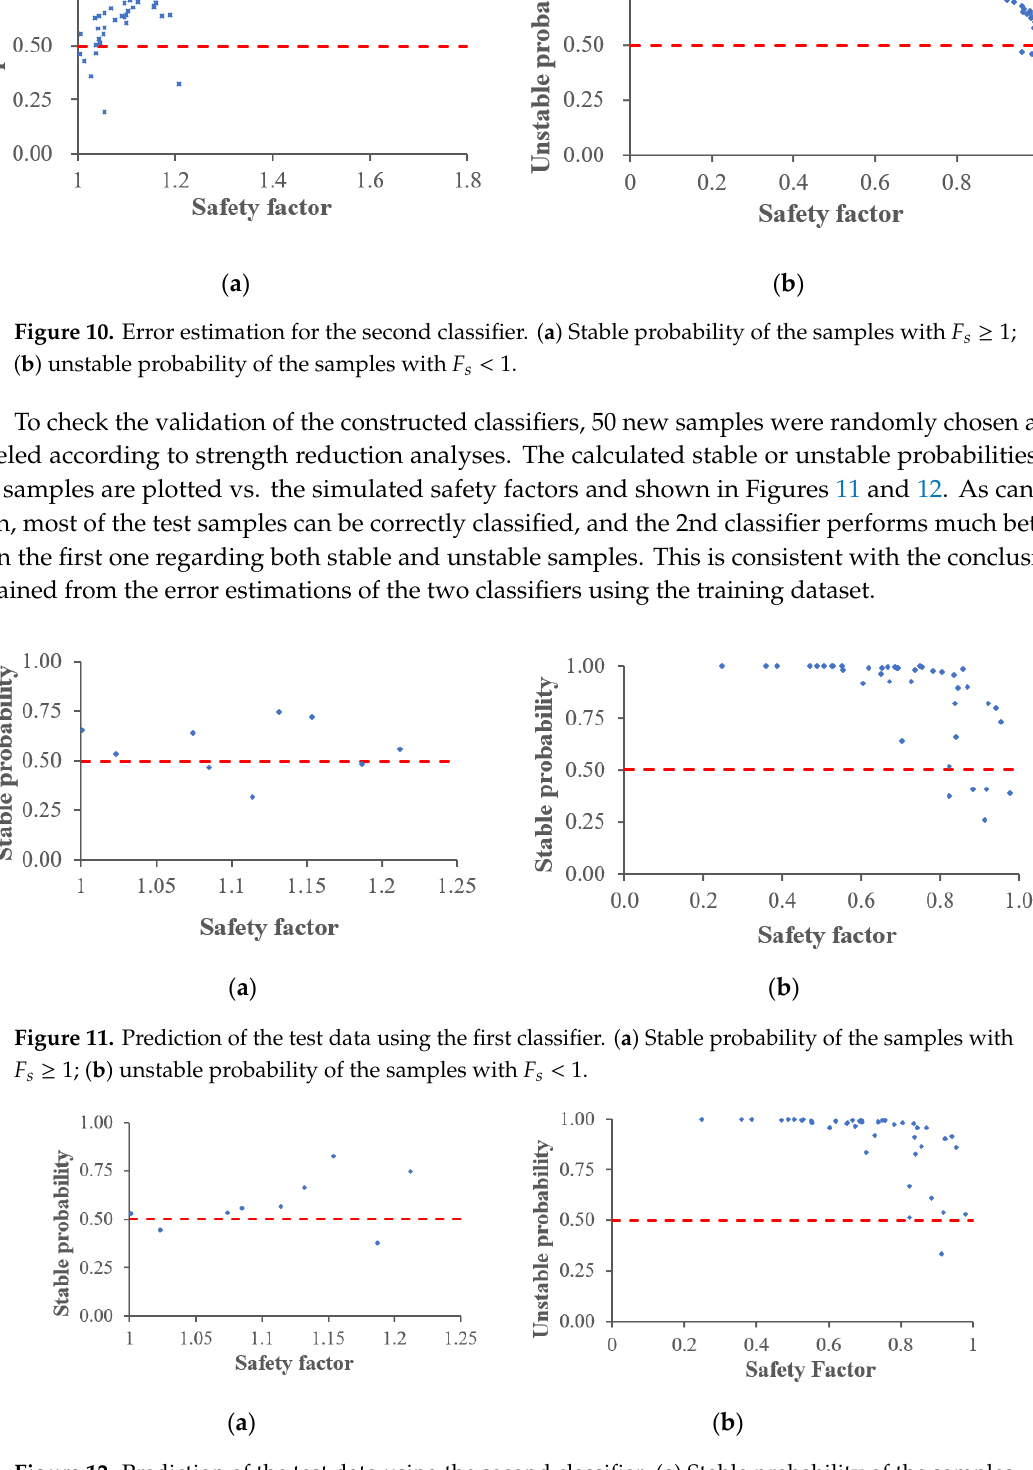
( d ) Figure 9. Updated PDFs of features with extra stable samples: ( a ) the cover depth; ( b ) the diameter; ( c ) the cohesive strength; ( d ) the friction angle.